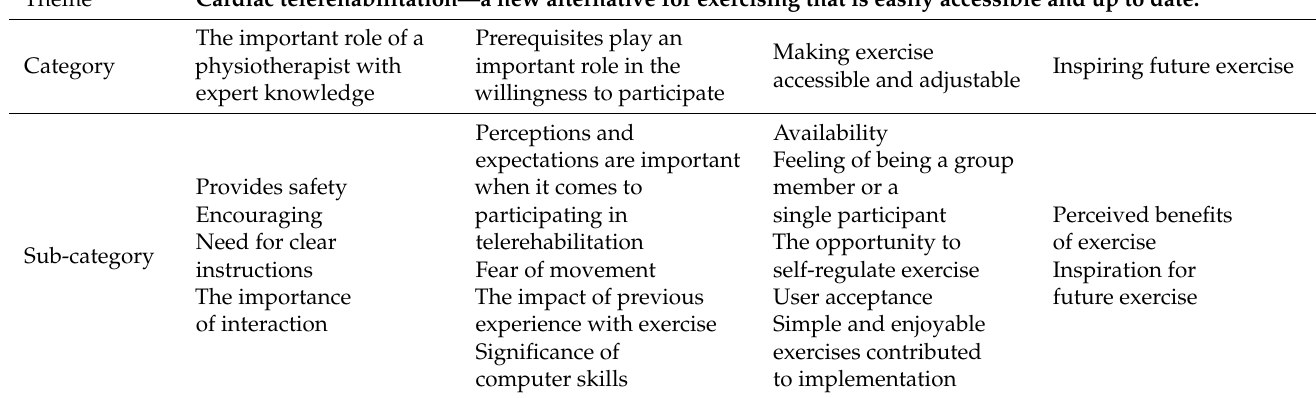
Table 2. Overview of categories, subcategories and overall